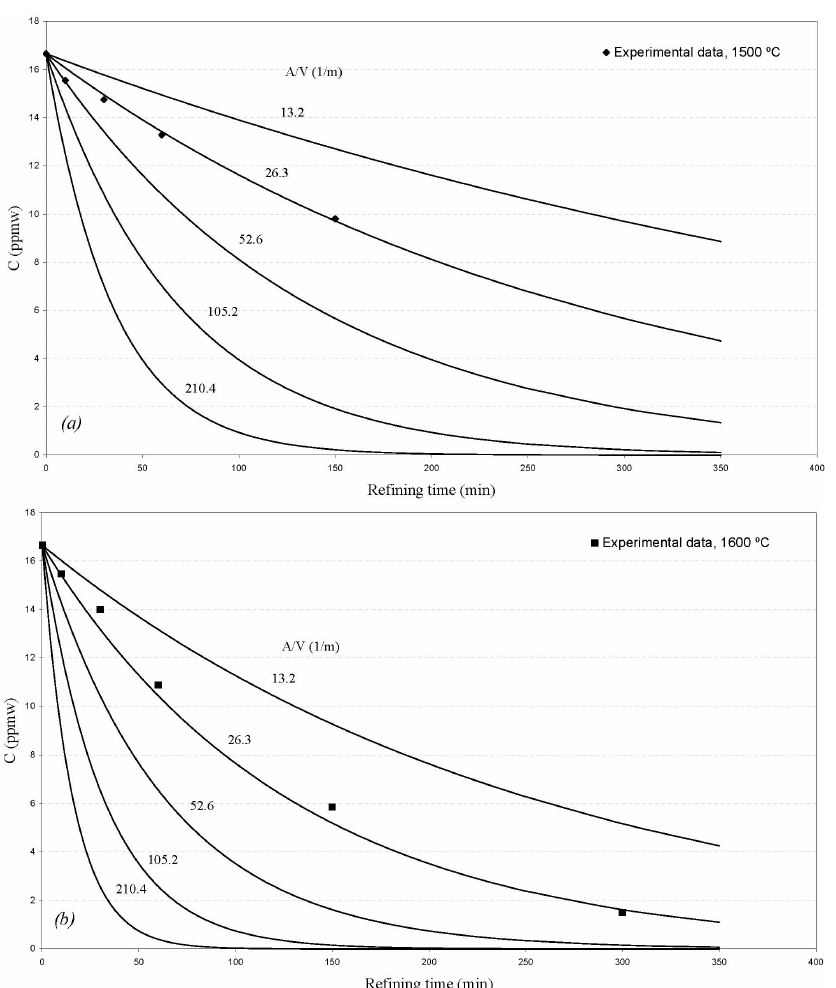
Figure 4. The changes of phosphorus concentration with refining time for different A=V ratios of the